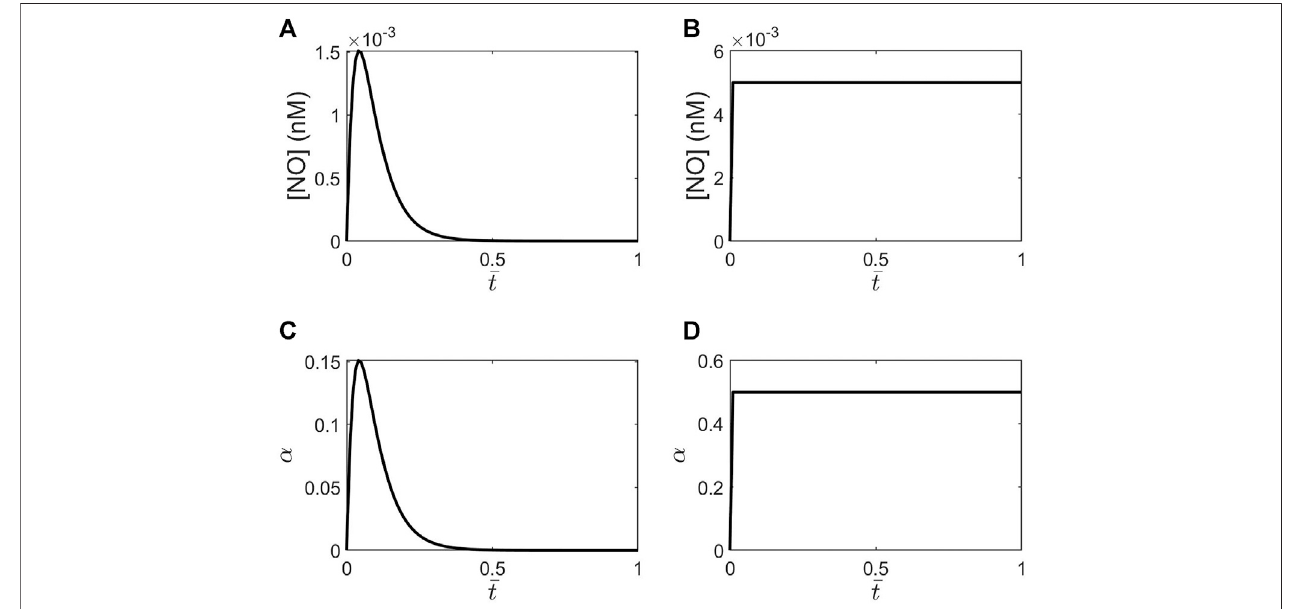
FIGURE3| PlotsofNOconcentrationsversusthedimensionlesstime (cid:2) t for (A) thedynamicsynthesisofNO( Eq.14 )and (B) thestepwisesynthesisofNO( Eq.13 ). The proposed shapes for the variable order α ( t ) corresponding to the two cases of NOS (A) and (B) are shown in plots (C) and (D) , respectively.